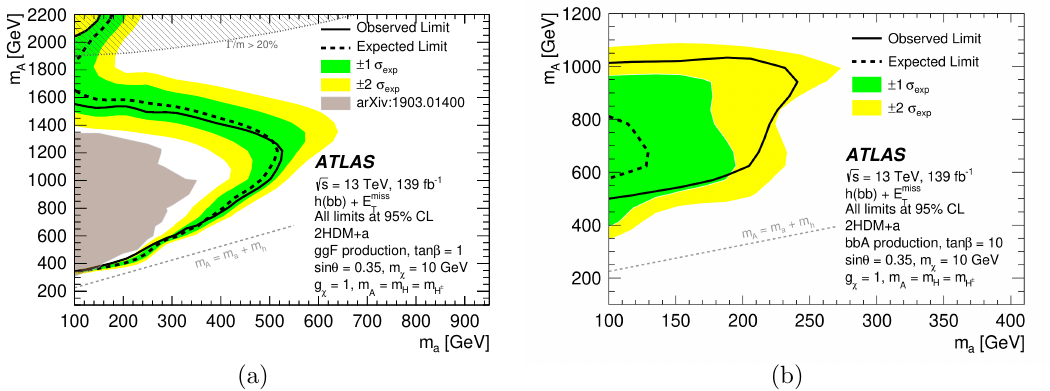
Figure 8. Exclusion limits for the 2HDM+ a signal with (a) tan β = 1 and gg F production and with (b) tan β = 10 and bbA production. The solid black line shows the observed limit at 95% CL, the dashed black line the expected limit. The green band gives the ± 1 σ uncertainties of the expected limit, the yellow band the ± 2 σ uncertainties. The hashed area in plot (a) indicates the region where the width of at least one of the Higgs bosons A , H or H ± or of the pseudoscalar a is above 20% of its mass. Extending the exclusion into this region would require additional assumptions within the 2HDM+ a model, and as such limits are not shown beyond 2 . 2